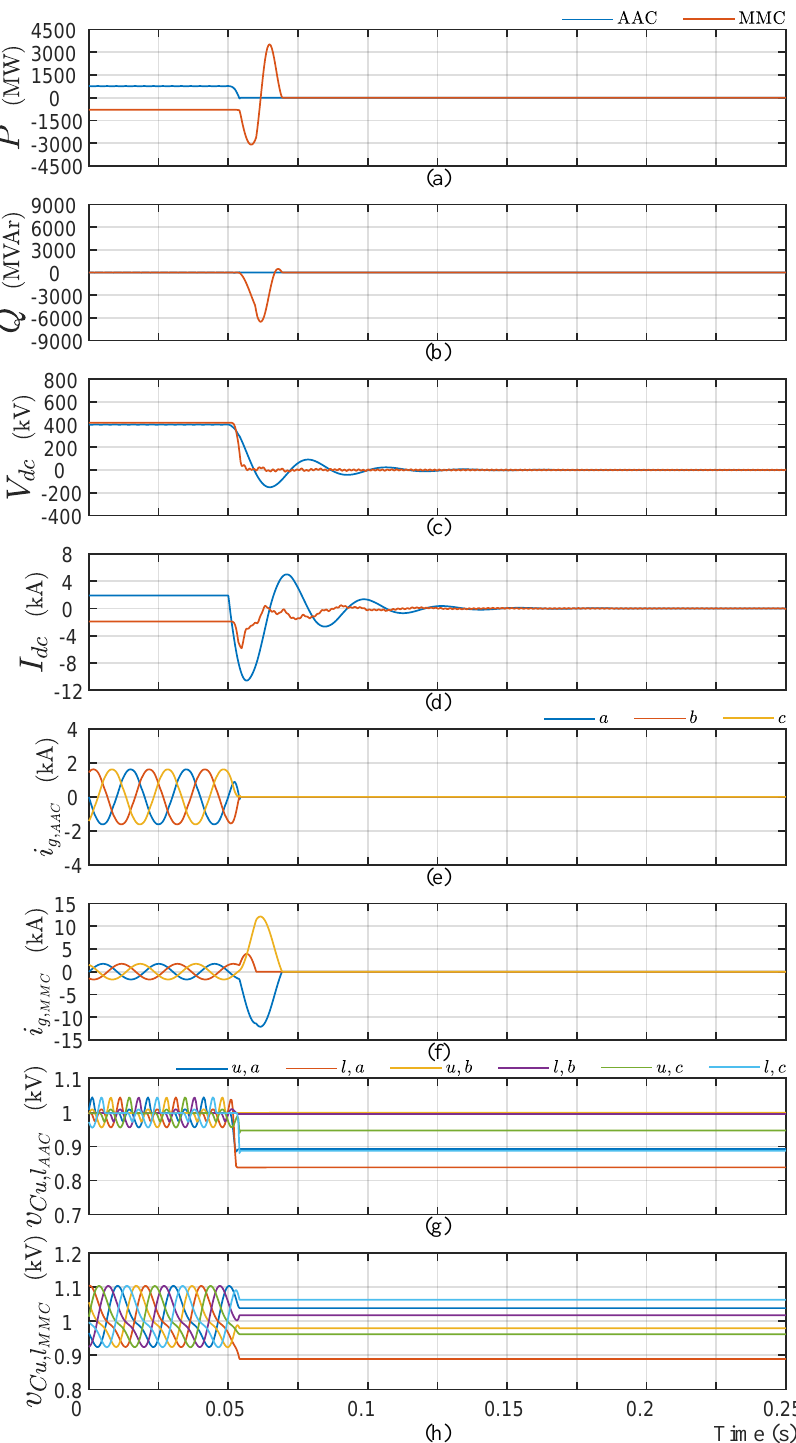
Figure 12. DC fault at the AAC dc bus (at 0.05 s): ( a ) active power, ( b ) reactive power, ( c ) dc-voltage, ( d ) dc-current, ( e ) ac currents of AAC, ( f ) ac currents of MMC, ( g ) SM capacitor voltages of AAC, and ( h ) SM capacitor voltages of